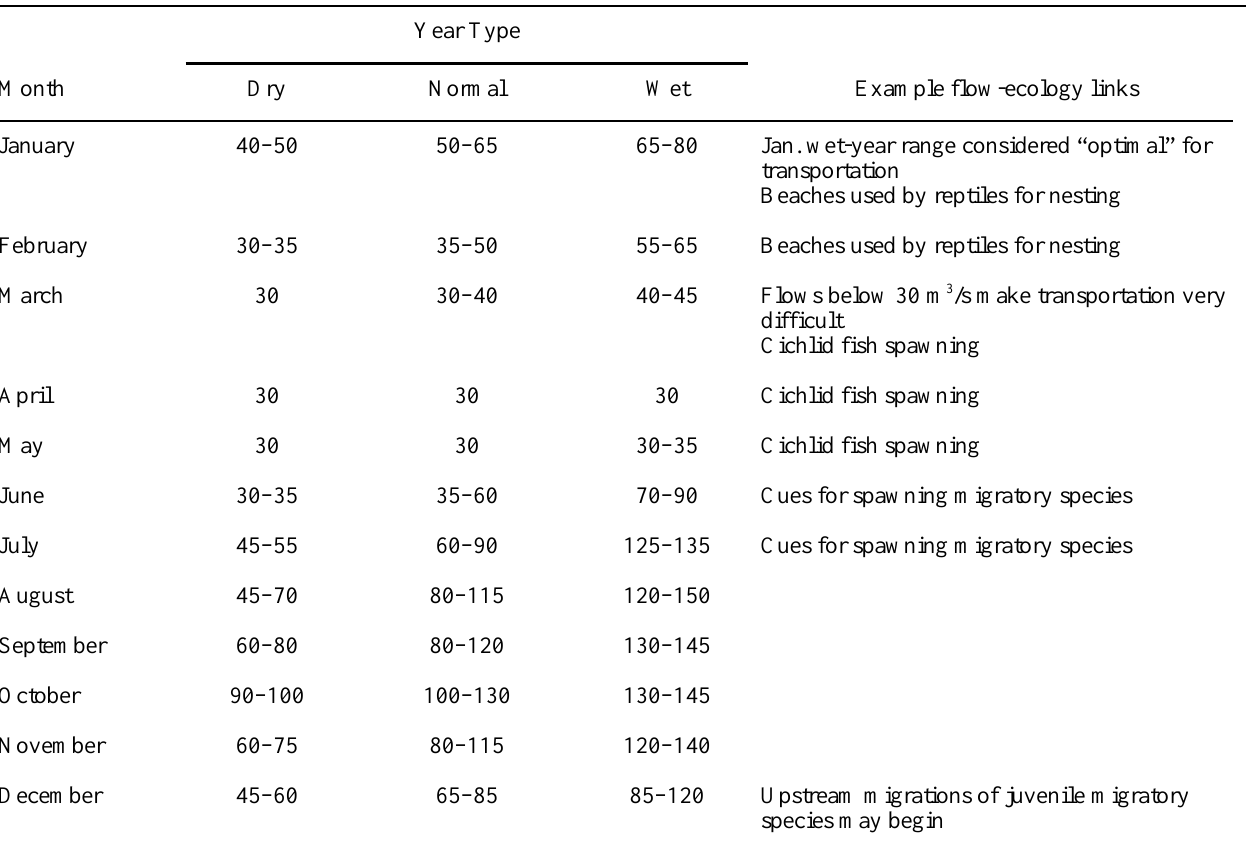
Table 3. Unified flow recommendation’s low flows for each month, for dry, normal, and wet years. Flow rates are cubic meters per second (m 3